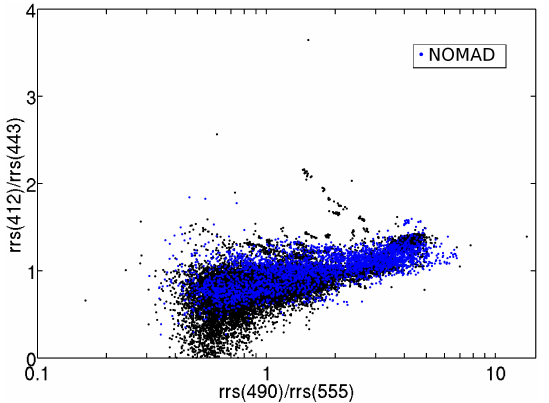
Figure 4. Ranges of remote-sensing reflectance band ratios (412:443 and 490:555) for all data. The points from the NOMAD dataset are shown in blue for reference. The total number of points is divided between MOBY (4513), AERONET-OC (17293), BOUS- SOLE (3533), NOMAD (3120), SeaBASS (432) and MERMAID (677). To maximise the number of ratios per dataset, a search win- dow of up to 12nm was used when the four wavelengths (412, 443, 490, 555) were not simultaneously available. The effect of different search windows was negligible in the ratio distribution.